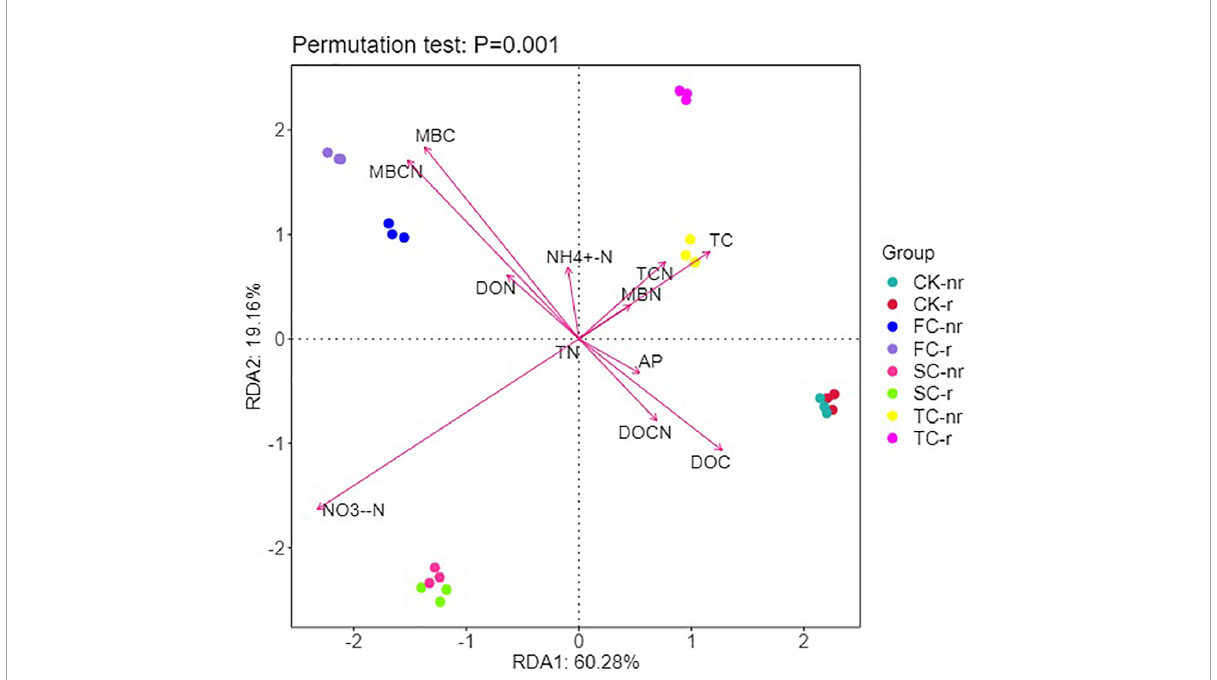
FIGURE8 Redundancy analysis (RDA) explains the impact of environmental variables (arrows) on the structure of bacterial community in different seedings and soil types (using rhizosphere soil and bulk soil data). The values for axis 1 and axis 2 are the percentages explained for the correspondent axes. Data were obtained from different successive planting generations and soil types (CK, Nanmu seedings; FCP, first-generation seedings; SCP, second-generation seedings; TCP, third-generation seedings; r, rhizosphere soil; nr, bulk